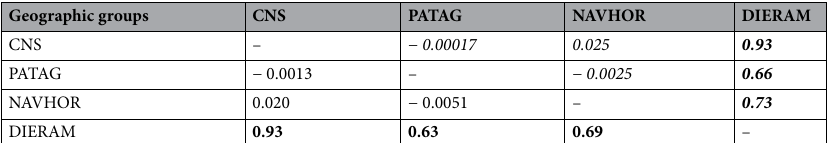
Geographic groups CNS PATAG NAVHOR